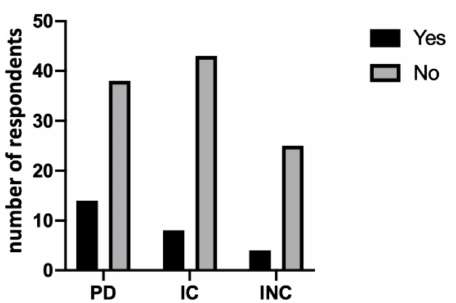
Figure 2. Oral hygiene differences (yes/no) between the three groups. No statistically significant differences were shown ( p = 0.23).